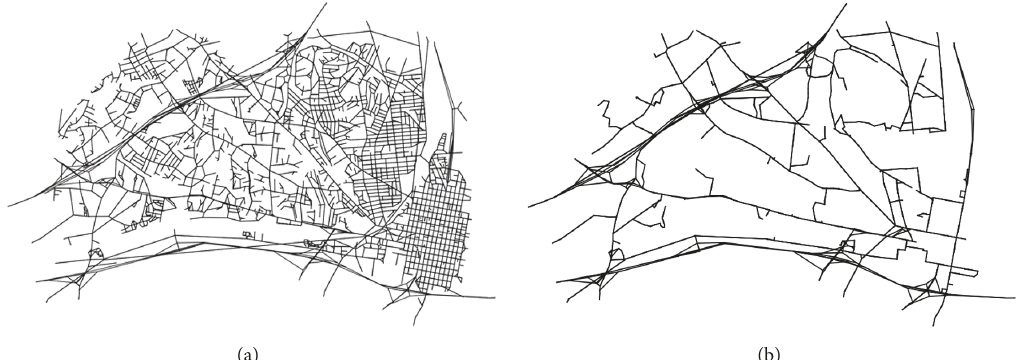
Figure 7: Analysis traffic maps: (a) original map, (b) sketch map.